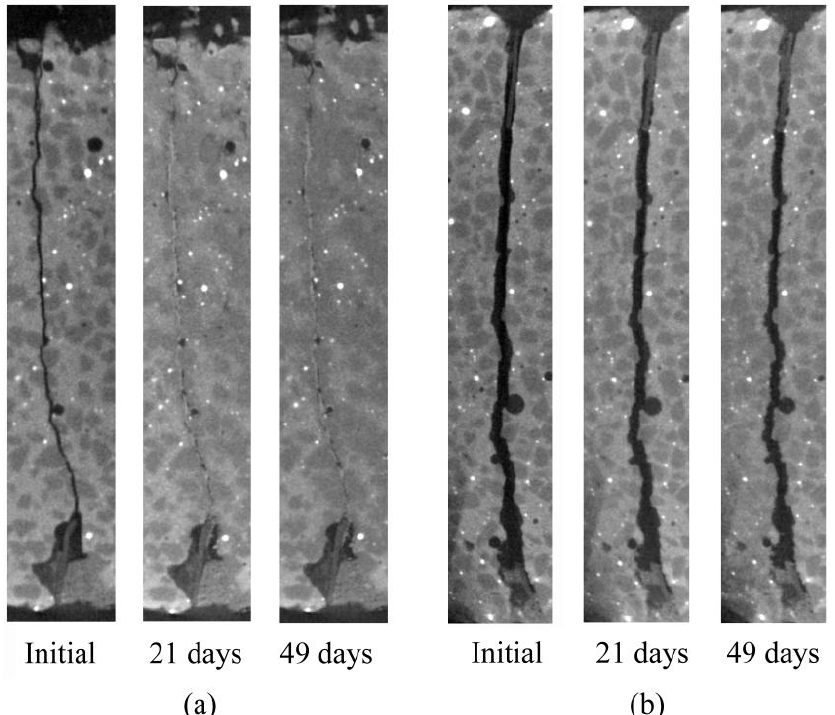
Figure 4. Comparison of CT images for a particular section near ( a ) End-I and ( b ) End-II. Height and width of each image are 14 and 2 mm,